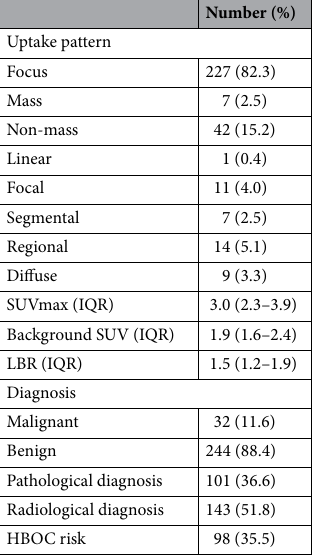
Table 1. Characteristics of incidental findings on dedicated breast PET. HBOC, hereditary breast and ovarian cancer; IQR, interquartile range; LBR, lesion-to-background ratio; SUVmax, maximum standardized uptake value.